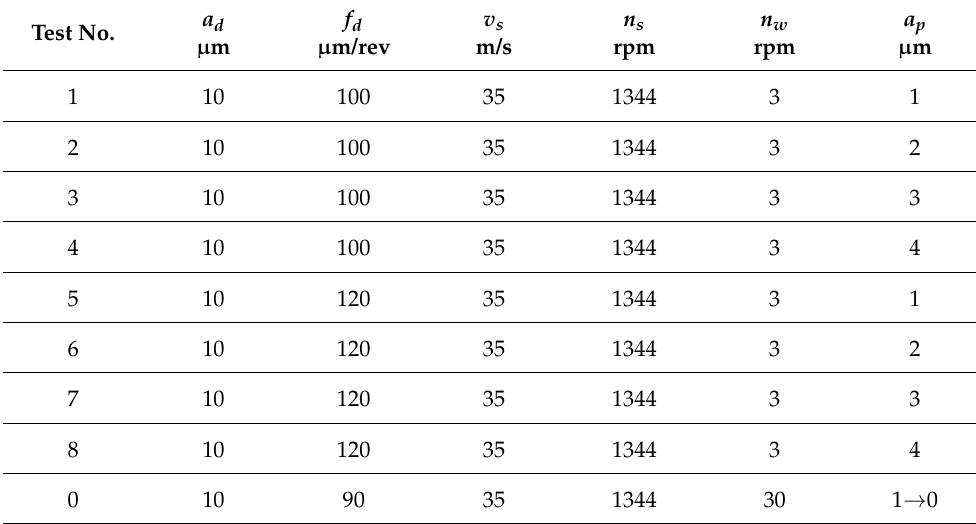
Table 1. Grinding experimental conditions.